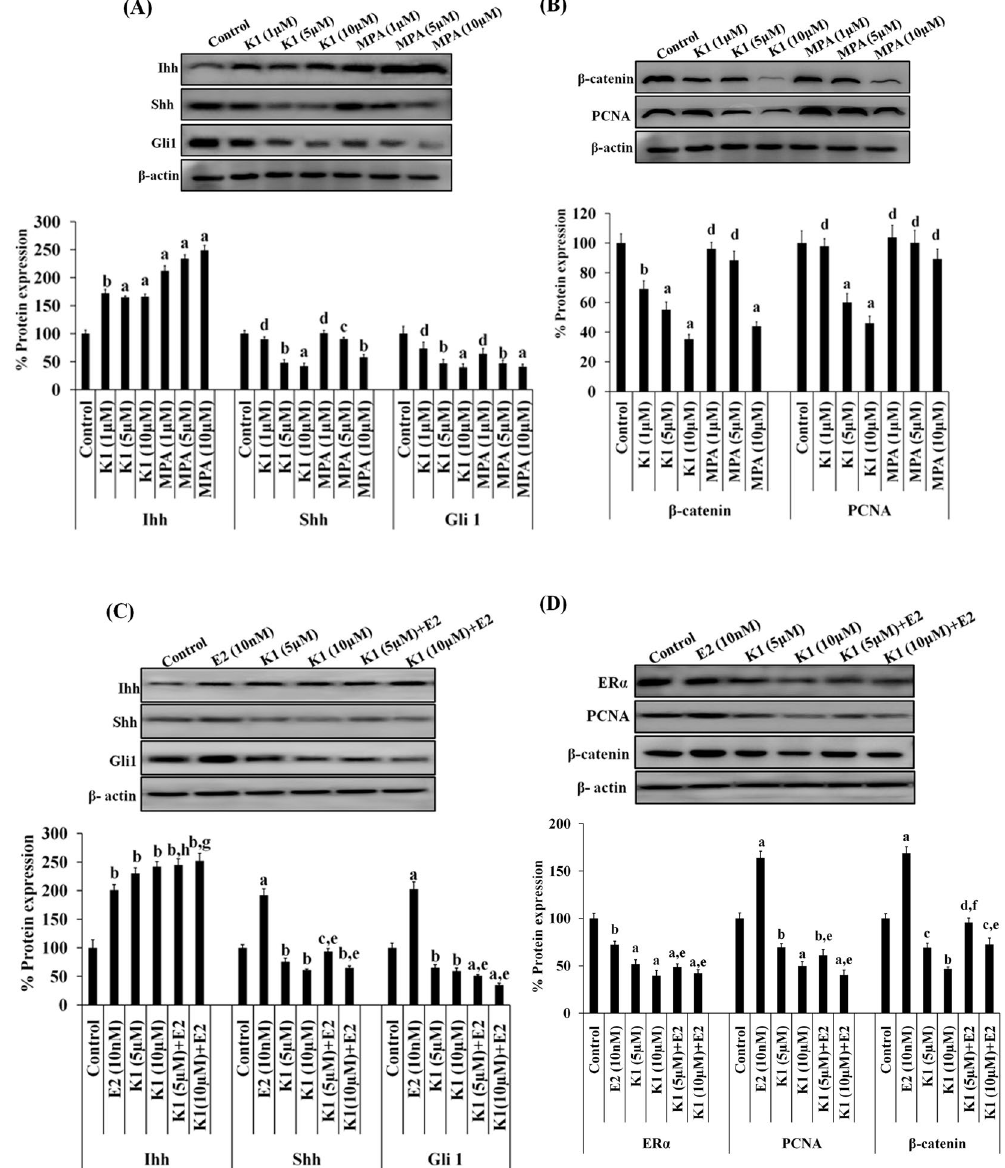
Figure 2. Anti-estrogenic agent (K1) or progestin (MPA) antagonizes estrogen- induced activation of Hh signaling molecules and proliferative markers in primary human EH cells. Representative western blots showing expression profile of Hh signaling molecules such as Ihh, Shh and Gli1 ( A ), and proliferative markers such as PCNA and β -catenin ( B ) in primary human EH cells treated with different concentrations of K1 or MPA. Representative western blots showing expression profile of Hh signaling molecules such as Ihh, Shh, Gli1 ( C ), and proliferative markers such as ER α , PCNA and β -catenin ( D ) in primary human EH cells treated with vehicle, E2 or anti-estrogenic agent K1 (5 μ M or10 μ M) with absence and presence of E2 (10 nM) for 48 h. β -actin was used as internal loading control. Densitometric data shown as % change in protein expression levels. Values are expressed as mean ± SEM, (n = 3 independent samples). p values: a p < 0.001, b p < 0.01, c p < 0.05 and d p > 0.05 vs. control; e p < 0.001, f p < 0.01, g p < 0.05 and h p > 0.05 vs. E2 - treated